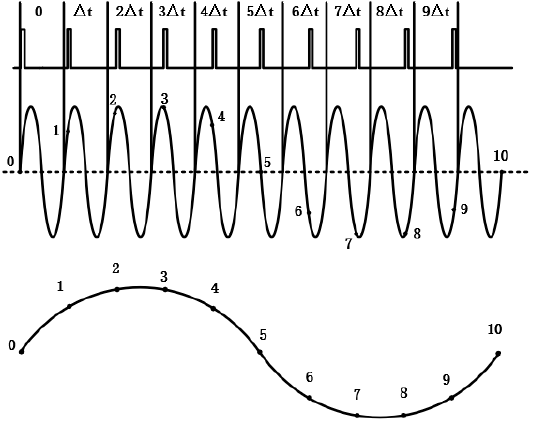
Figure 1. Schematic of sequential equivalent sampling.